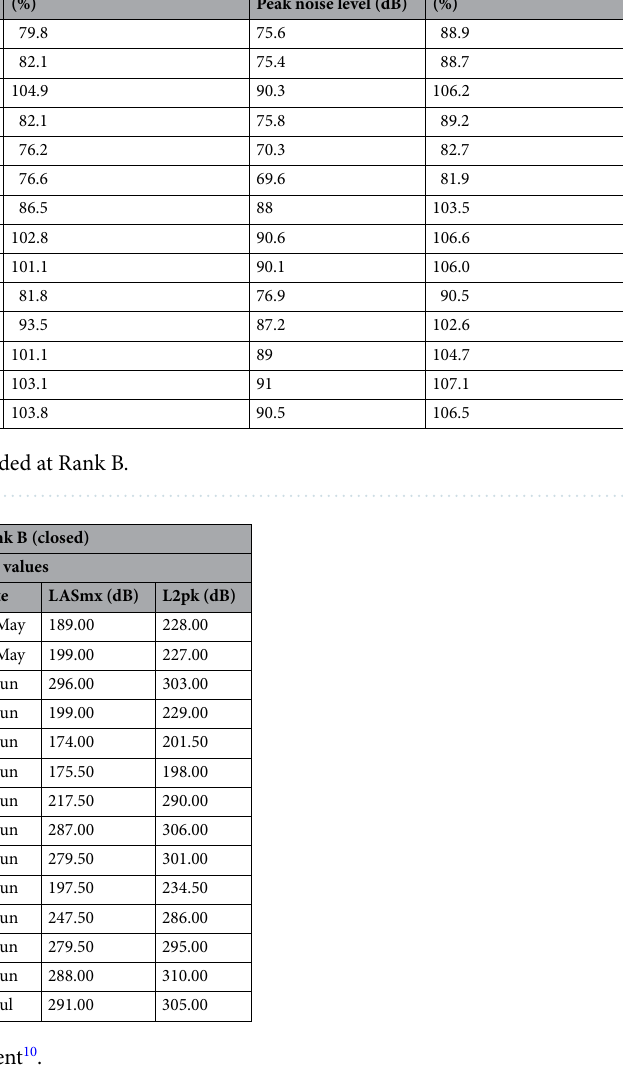
Table 9. Standard index measurement 10 .